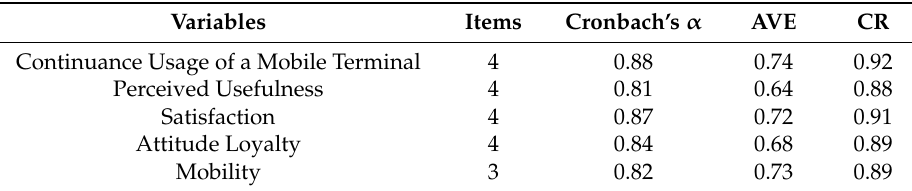
Table 3. Results of reliability.